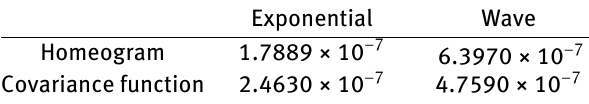
Table 1: The quality of fit for the spatial coherency functions.